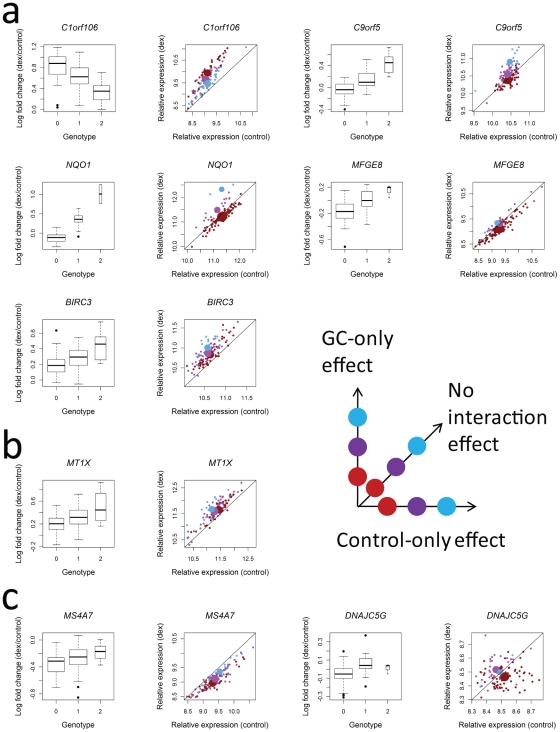
Patterns of interaction between genotype and GC treatment that underlie associations with log fold change for each of the 8 genes where log fold change is significantly associated with genotype at a SNP within 100 kb.Plots on the left show the effect of genotype on log2 fold change, with genotype coded as copies of the minor allele. In plots on the right, each small dot corresponds to an individual and is color coded based on genotype (red = homozygous for major allele, purple = heterozygous, and blue = homozygous for minor allele). Large dots represent genotypic means. Associations are classified based on the configuration of genotypic effects in the two conditions, including a) genotypic effects only in GC-treated samples, b) genotypic effects only in control-treated samples and c) genotypic effects in both conditions that differ. On the right is a cartoon showing patterns of interaction in two-dimensional space with expression after GC-treatment on the y-axis and expression after control-treatment on the x-axis. Each of the three dots on each line corresponds to the mean value for a genotype class (red = homozygous for major allele, purple = heterozygous, and blue = homozygous for minor allele). Genotype is coded as copies of the minor allele. Relative expression corresponds to log2-transformed microarray intensities.